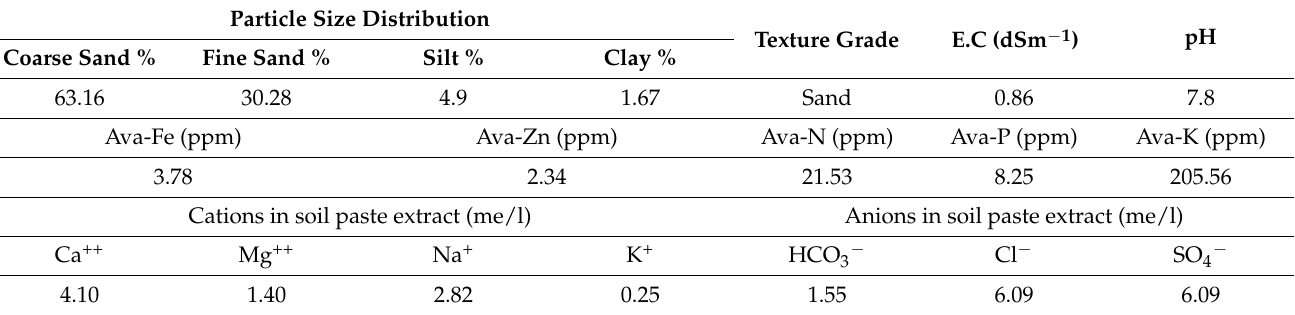
Table 8. Physical and chemical properties of the experimental soil.